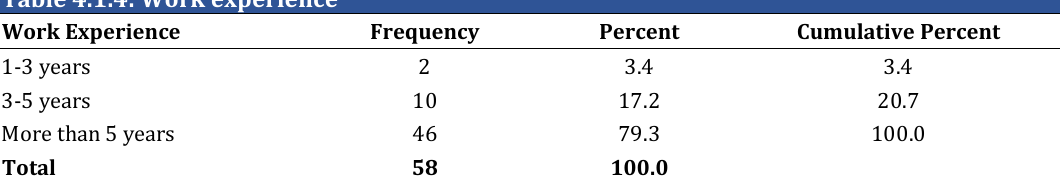
Table 4.1.4: Work experience